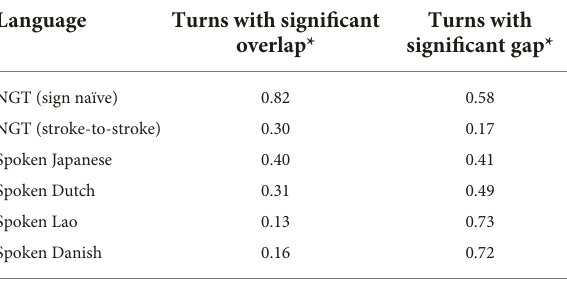
TABLE 3 Turn overlaps and gaps in Sign Language of the Netherlands (NGT) versus spoken